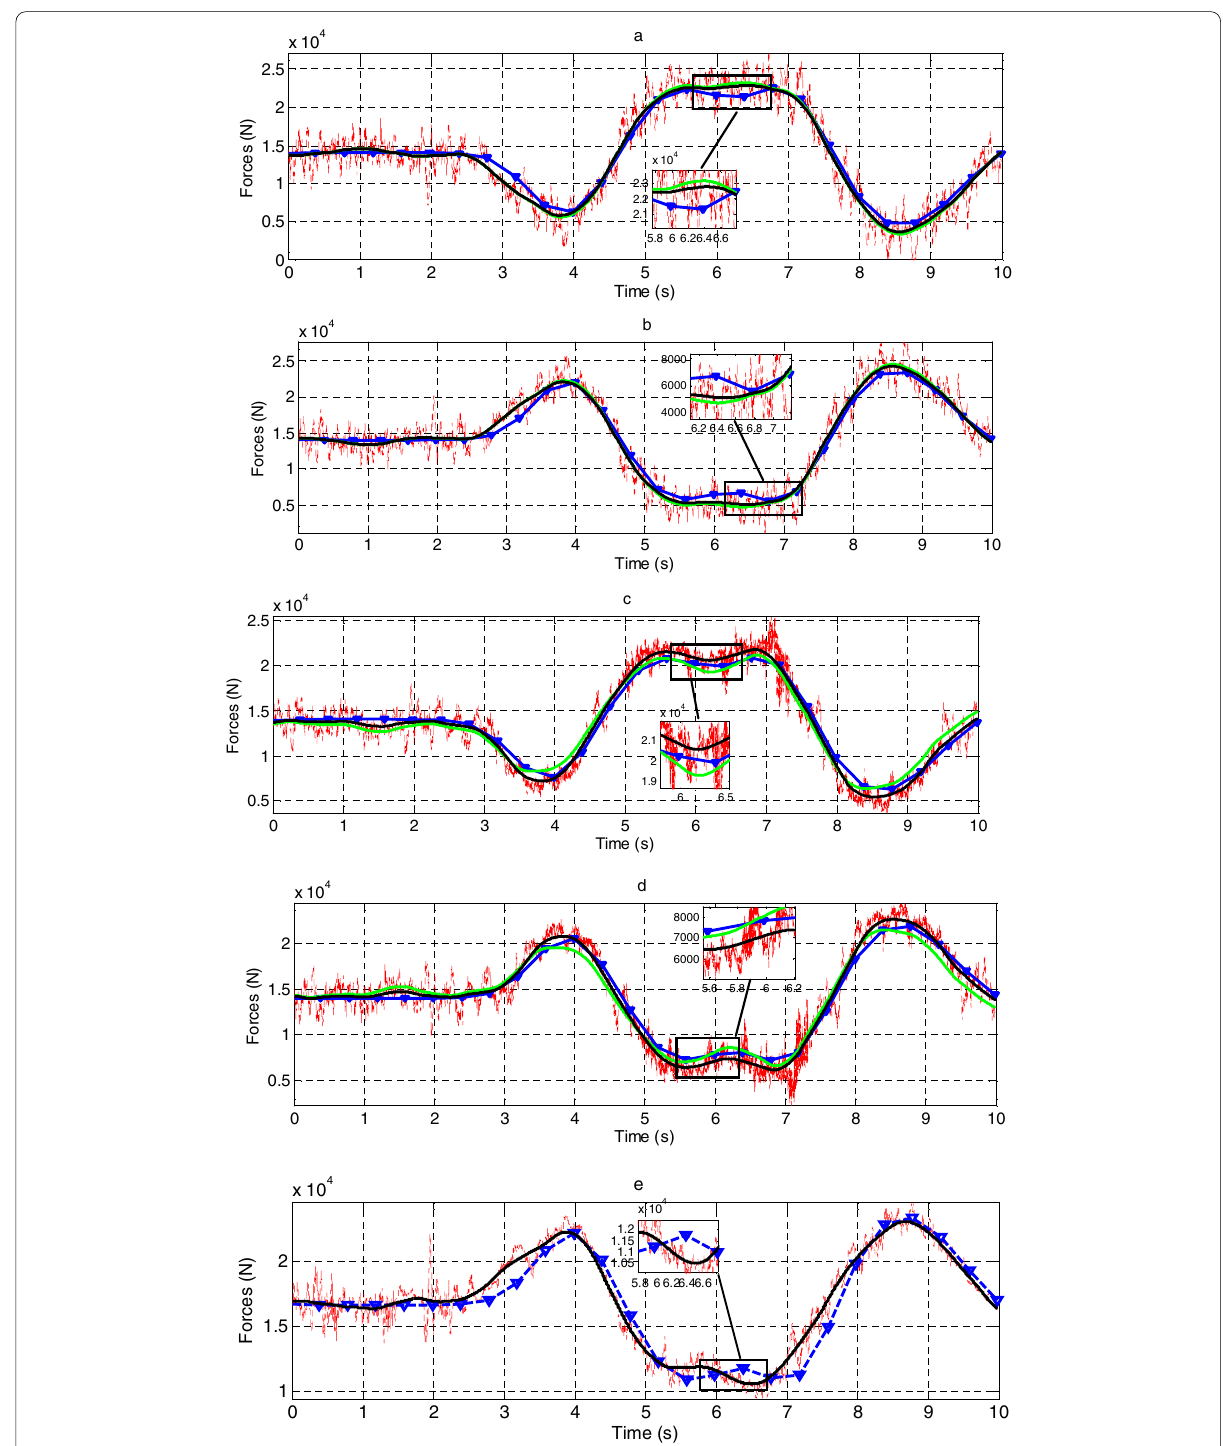
Figure 8 Comparisons between Trucksim and estimation under Condition